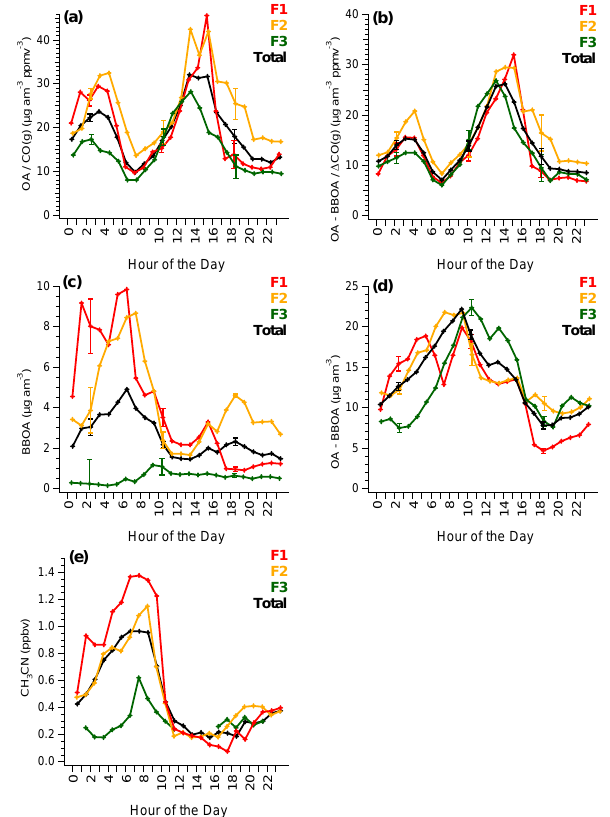
Fig. 11. Diurnal profiles for (a) OA/ 1 CO(g), (b) OA- BBOA/ 1 CO(g), (c) BBOA, (d) OA-BBOA, and (e) CH 3 CN at T0 during the whole campaign (“Total”) and the three different fire im- pact periods (high fire: F1, F2; low fire: F3). Error bars are the standard error of the data points for each period, and are shown only at selected points to avoid excessive clutter on the